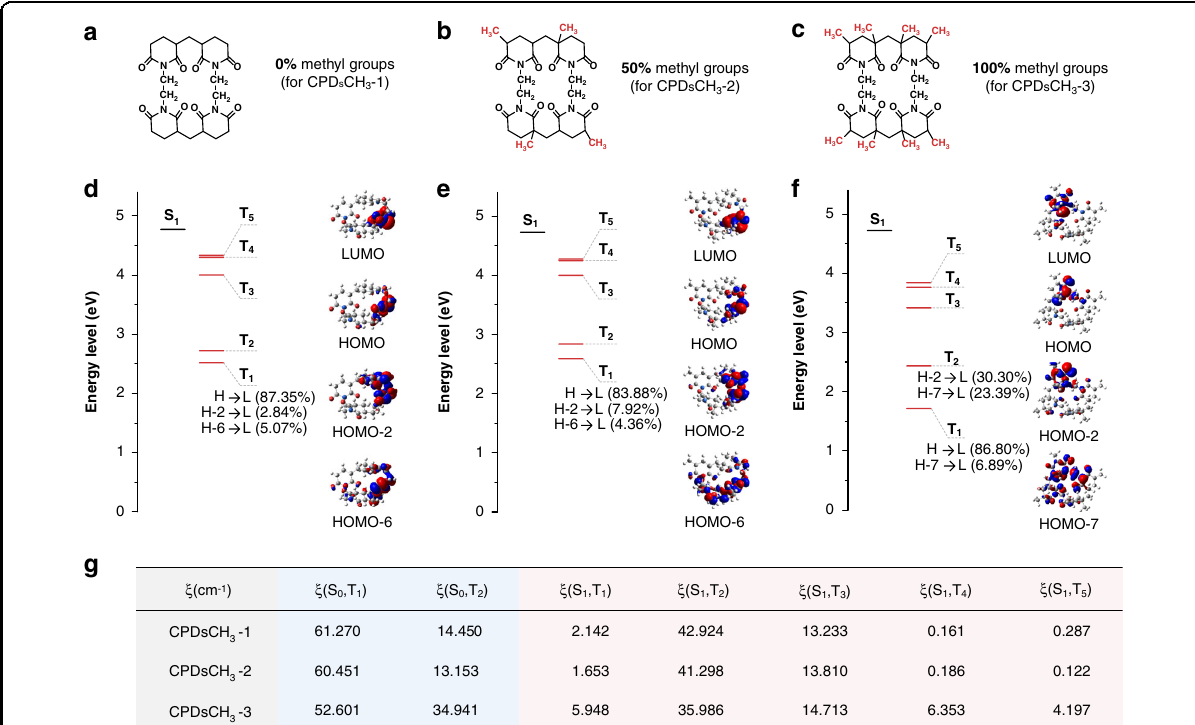
Fig. 5 Results of theoretical calculations carried out with CPDs. Simpli fi ed luminescent units for in a CPDsCH 3 -1, b CPDsCH 3 -2, and c CPDsCH 3 -3. Energy-level diagrams of simpli fi ed luminescent units in d CPDsCH 3 -1, e CPDsCH 3 -2, and f CPDsCH 3 -3. g Corresponding SOC coef fi